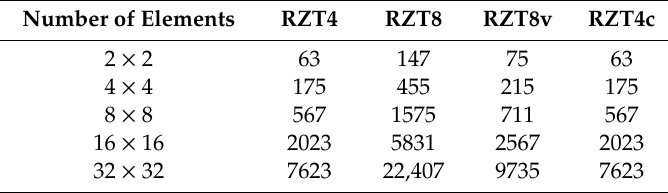
Table 5. Dof’s for the various mesh discretization and for each element.